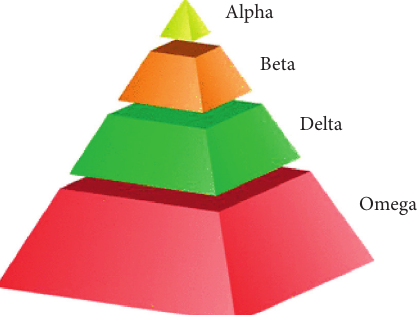
Figure 1: Social hierarchy of the group of Grey Wolves